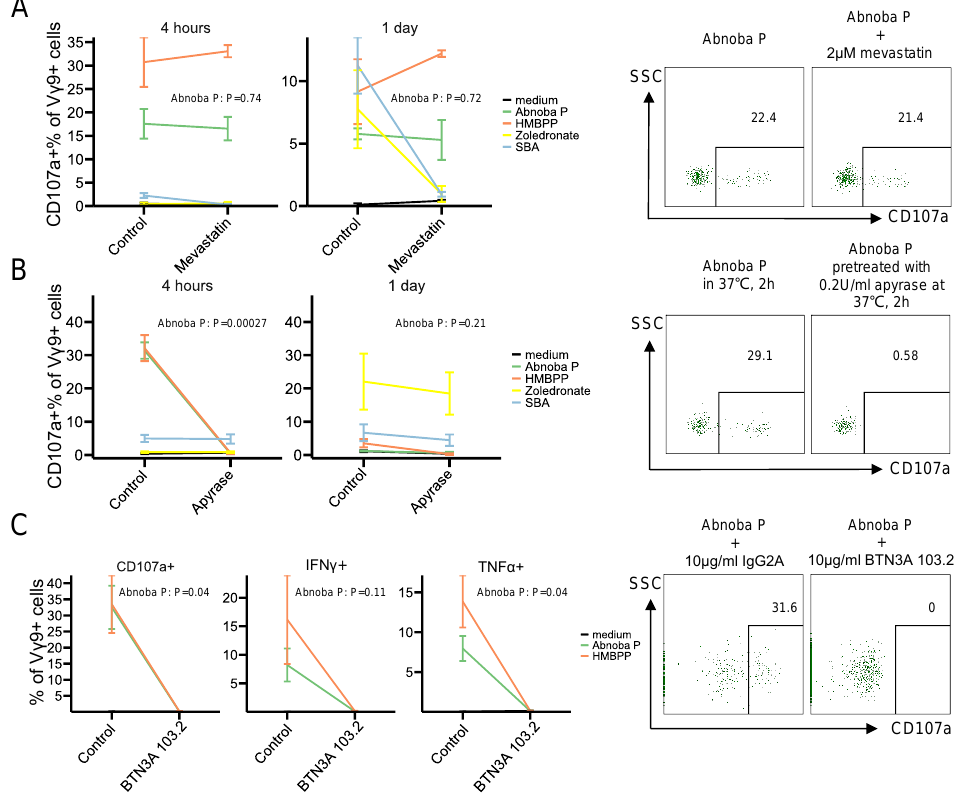
Figure 3. AbnobaViscum stimulation of V γ 9V δ 2 T cells is direct and BTN3A-dependent. ( A ) CD107a expression on V γ 9 + T cells upon mevastatin treatment within each stimulation. Lines connect the mean values between control and mevastatin treatment within the same stimulation, error bars show mean ± sem ( n = 3). Representative flow cytometry plots after 4 h stimulation are on the right of the graphs (gate on CD3 + V γ 9 + T cells). ( B ) CD107a expression on V γ 9 + T cells upon apyrase treatment within each stimulation. Lines connect the mean values between control and apyrase treatment within the same stimulation, error bars show mean ± sem ( n = 5 for 4 h, n = 3 for 1 day). Representative flow cytometry plots after 4 h stimulation are on the right of the graphs (gate on CD3 + V γ 9 + T cells). ( C ) CD107a (left), IFN γ (middle), TNF α (right) expression in V γ 9 + T cells upon blocking BTN3A within each stimulation for 4 h. Lines connect the mean values between isotype control and BTN3A 103.2 mAb within the same stimulation, error bars show mean ± sem ( n = 3). Representative CD107a stainings (4 h stimulation) after are on the right of the graphs (gate on CD3 + V γ 9 + T cells). Values on the graphs indicate p values (obtained with paired T-test).